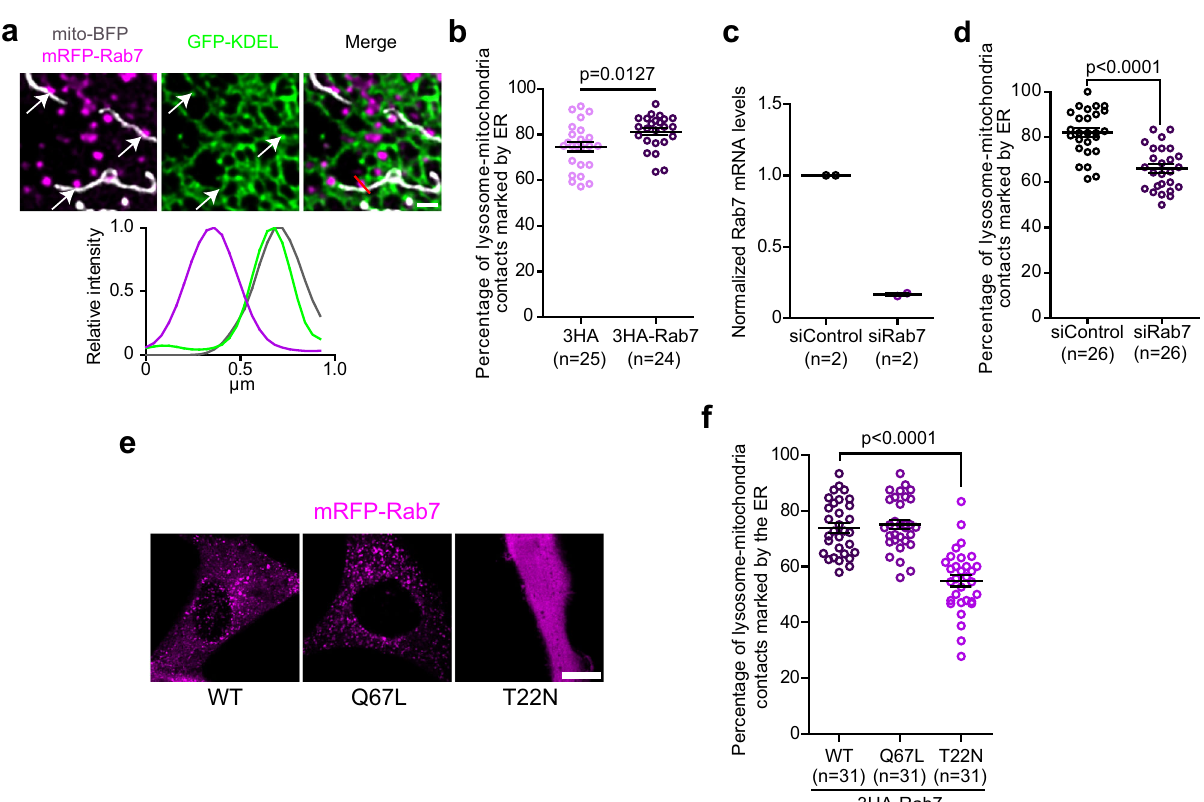
Fig. 2 Rab7 regulates a subset of ER-lysosome-mitochondria three-way contacts. a Representative image of Rab7 positive lysosomes-mitochondria contacts that are marked by the ER in HeLa cells expressing mRFP-Rab7, GFP-KDEL, and mito-BFP. White arrows indicate the lysosome-mitochondria contacts. Line-scan analysis of relative fl uorescence intensities (left to right) from the red line shown in merge. Scale bar: 1 µ m. b Quanti fi cation of the percentage of lysosome-mitochondria contacts marked by the ER in HeLa cells expressing either a wild-type Rab7 or a control vector, with mito-BFP, GFP- KDEL, and Lamp1-mCherry. The graphs show the mean ± SEM, cells from three independent experiments. Two-sided unpaired t -test. c Normalized Rab7 mRNA levels in cells transfected by a siRNA targeting speci fi cally Rab7 or a control siRNA measured by RT-qPCR. The graphs show the mean ± SEM, cells from two independent experiments. d Quanti fi cation of the percentage of lysosome-mitochondria contacts marked by the ER when Rab7 expression level was downregulated by a siRNA targeting Rab7 compared to a control siRNA in cells expressing Lamp1-mCherry, mito-BFP, and GFP-KDEL. The graphs show the mean ± SEM, cells from three independent experiments. Two-sided unpaired t -test. e Representative images of HeLa cells expressing the wild- type (WT), constitutively active (Q67L), or dominant negative (T22N) mRFP-Rab7. Note that the dominant negative Rab7 (T22N) does not localize to lysosomes but is cytosolic. Scale bar: 10 µ m. f Quanti fi cation of the percentage of lysosome-mitochondria contacts that are marked by the ER in HeLa cells expressing either the 3HA-Rab7 or its mutants with Lamp1-mCherry, mito-BFP, and GFP-KDEL. The graph shows the mean ± SEM, Cells from three independent experiments. One-way ANOVA with Dunnett ’ s Multiple Comparison